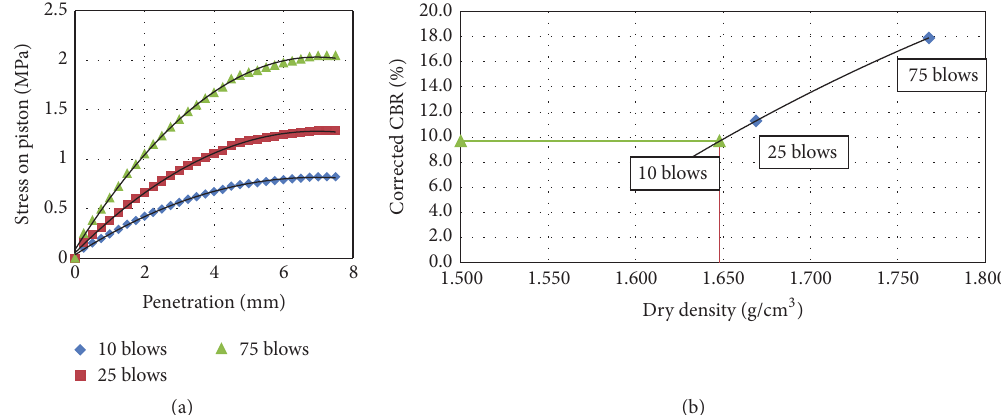
Figure9:(a)Relationshipbetweenresistanceandpenetrationforsoilwith10%FSSAadditives.(b)CBRvalueforsoilwith10%FSSAadditives. Table 6: Effect of the FSSA additive content on the unconfined compressive strength and strain at